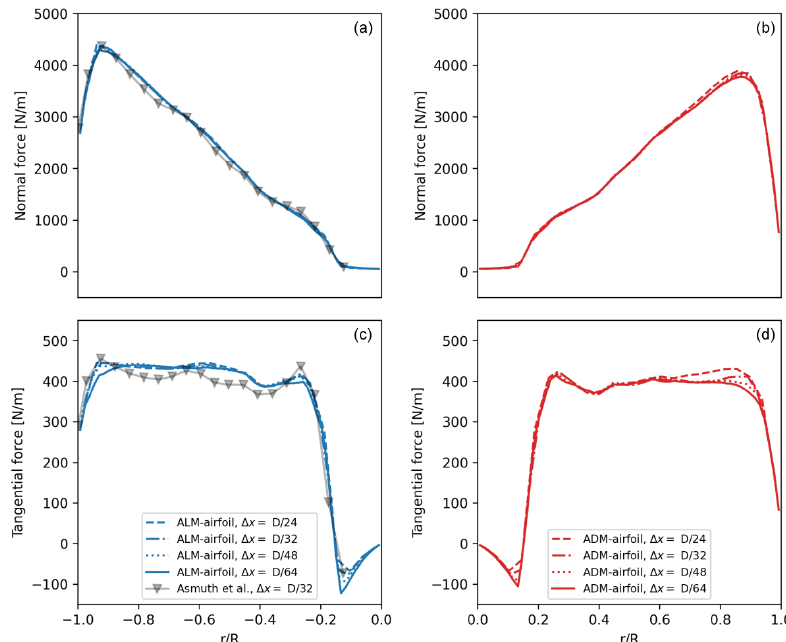
Figure A2. Mesh sensitivity study for the ADM-airfoil and the ALM-airfoil: normal f n (a, b) and tangential f θ (c, d) force distributions along the blade using different mesh resolutions. The EllipSys LES result from Asmuth et al. (2020) for the D/ 32 resolution of the ALM- airfoil (no tip correction) is also plotted.